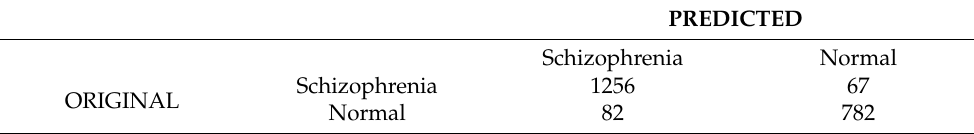
Table 2. EEG Gramian Angular Field confusion matrix.